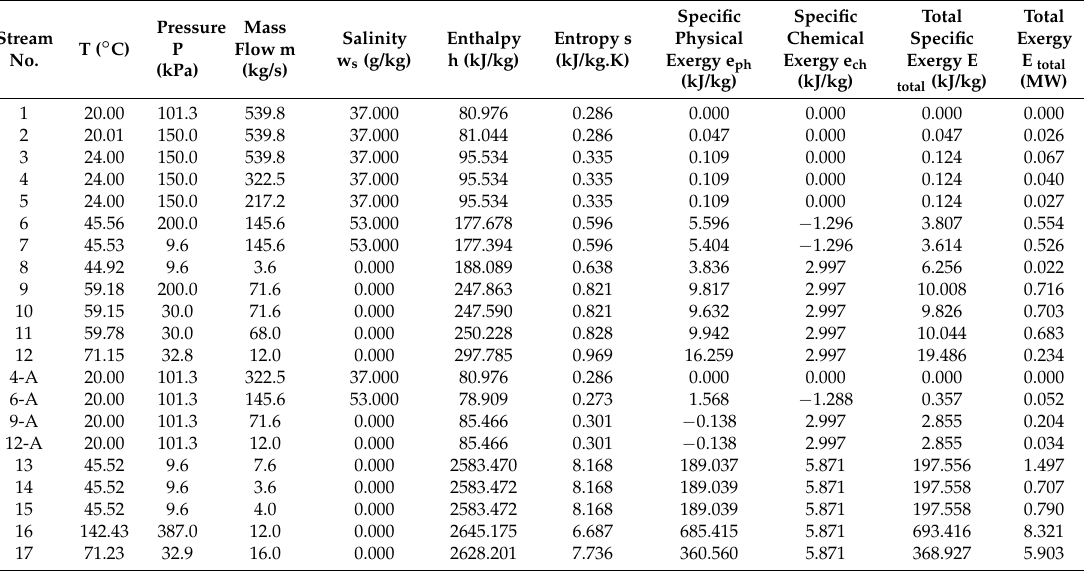
Table 4. Exergetic data of all streams in the proposed system without preheating.